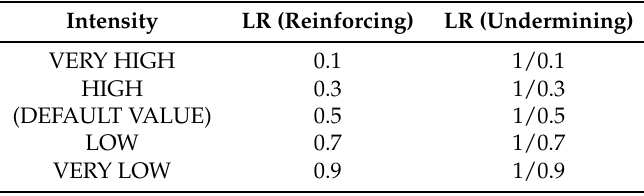
Table 1. Mapping between Likelihood Ratios and